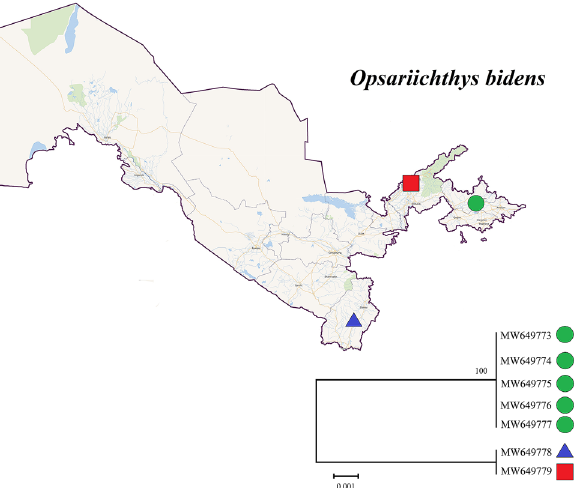
Figure 2. Neighbour-joining tree of Opsariichthys bidens from DNA barcode sequences with 100 000 bootstrapping replicates. Sampling localities: Syr Darya (green circle), Chirchik River (red square), and Surkhan Darya (blue triangle).